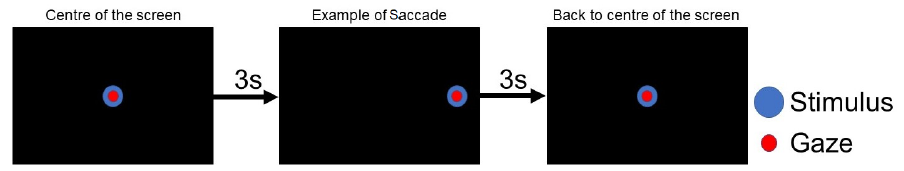
Figure 4. Horizontal visually guided saccade test.